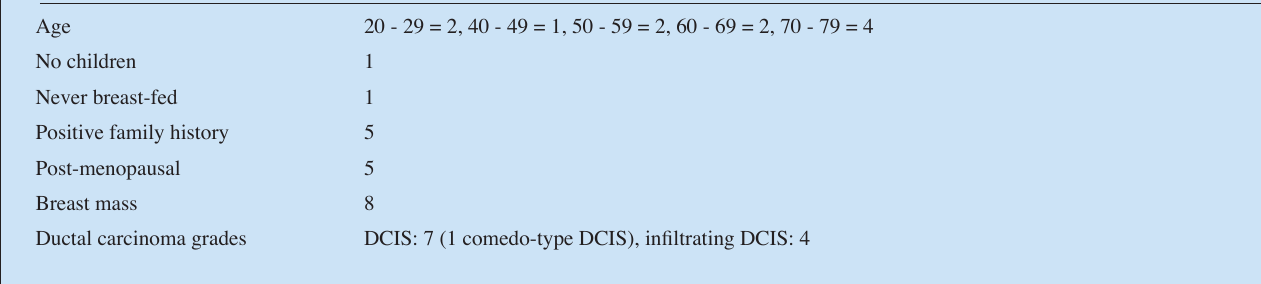
Table II. Clinical and other relevant history in patients with ductal carcinoma